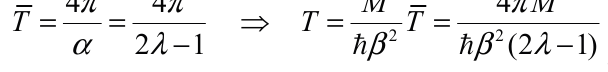
; ( b ) The time responses (cid:2915)(cid:2927) = 0.3840 , (cid:1846)(cid:3364) = 0.2496 , (cid:1846)(cid:3364) = 0.1203 , (cid:2892) (cid:3118) (cid:2892)(cid:2887)(cid:2922) (cid:2899) (cid:3118)